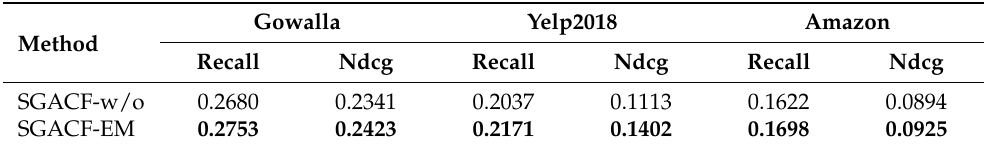
Figure 5. Performance comparison of different item groups SGACF-EM and SGACF-w/o. Table 4. Impact of self-supervised learning on